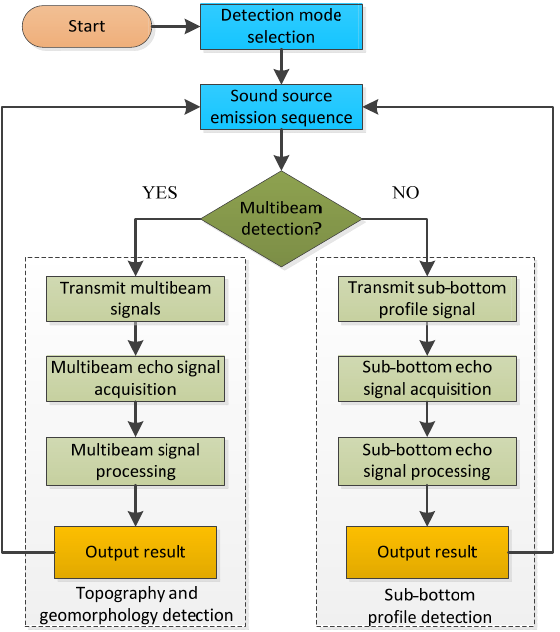
Figure 4. Schematic diagram of the principle of integrated seabed detection.